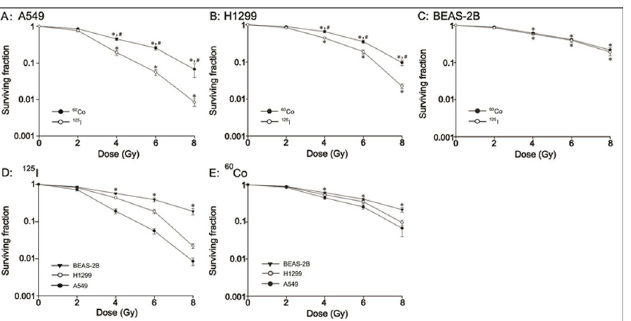
Fig 1. Clonogenic survival fraction of A549, H1299 and BEAS-2B cells irradiated with 125 I seeds and 60 Co γ -rays. A-C: the difference in the survival fraction of A549, H1299 and BEAS-2B cells between 125 I seeds CLDR radiation and 60 Co γ -ray HDR radiation. * indicates a significant difference (P < 0.05) when comparing the two radiation treatments and control treatment, and # indicates a significant difference (P < 0.05) when comparing 125 I seeds CLDR radiation and 60 Co γ -ray HDR radiation of the same doses. D, E: The difference in the survival fraction of the three cell lines receiving the same treatment. * indicates a significant difference (P < 0.05). Bars, standard error